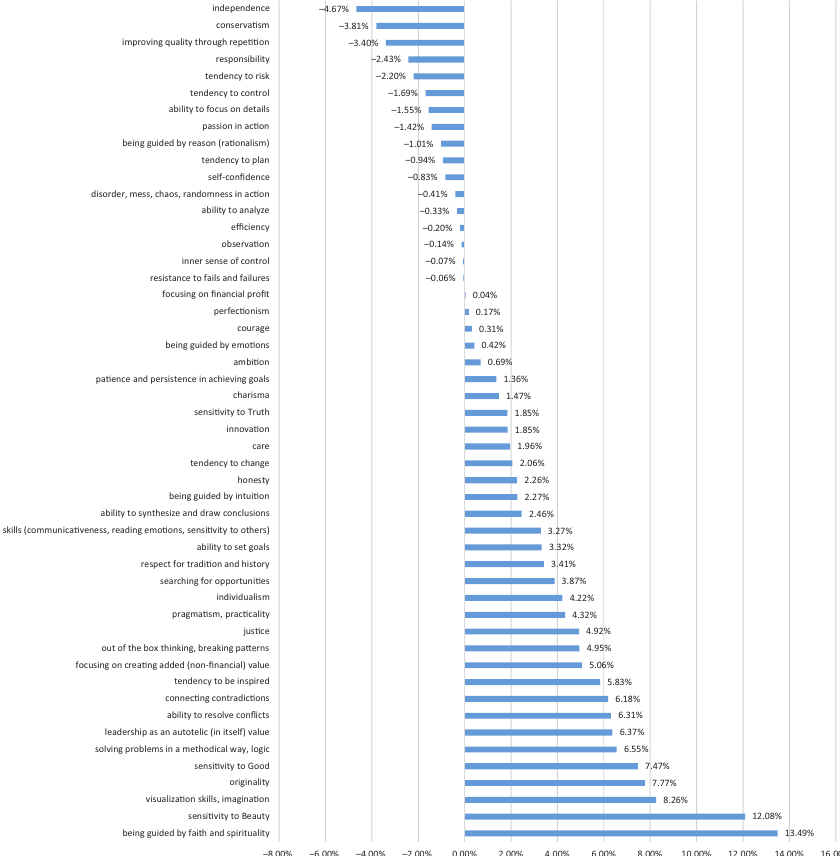
Figure 6. Perception of the 50 features of an entrepreneur’s identity by artistic versus non-artistic individuals (source: created by